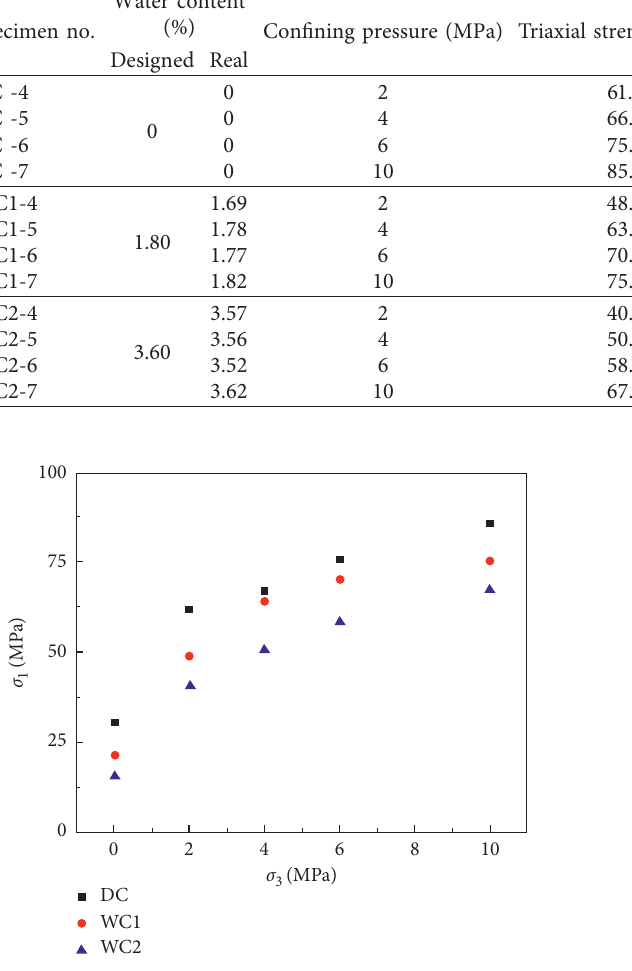
Figure 8: Relation between confining pressure and strength.